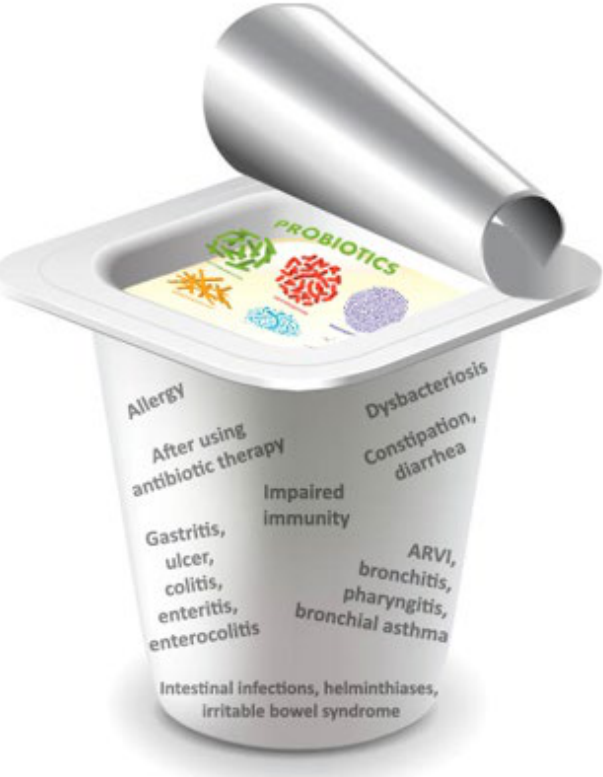
Figure 2. Health benefits of probiotic bacteria (adapted from Linares et al. [102]).